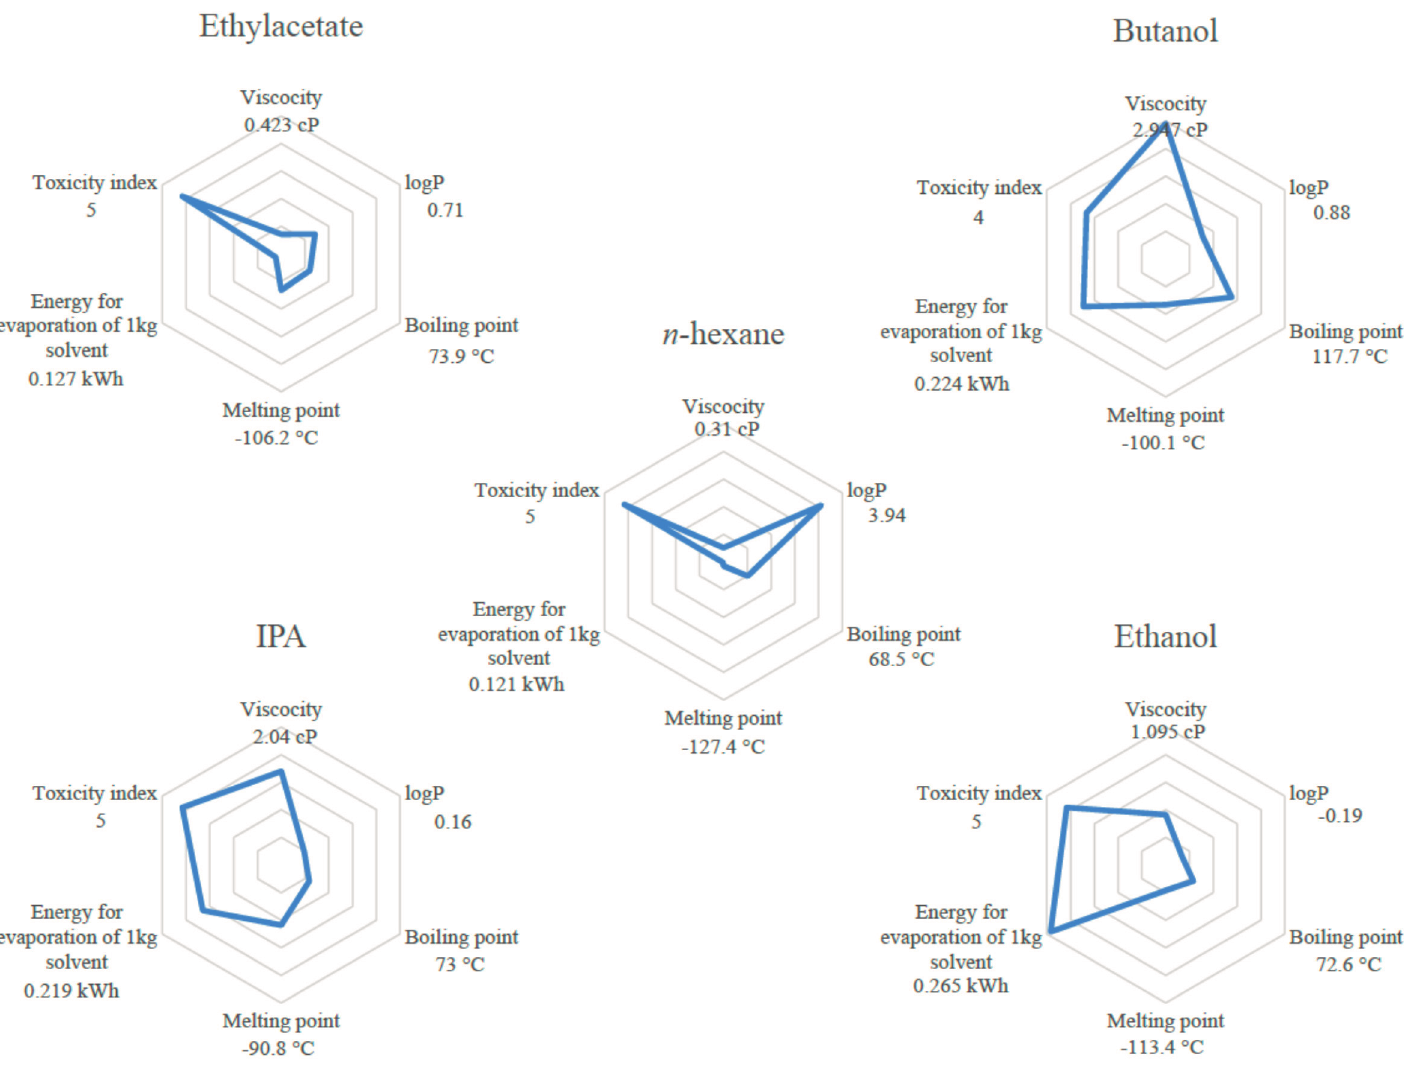
Figure 2. Properties of solvents vs. n